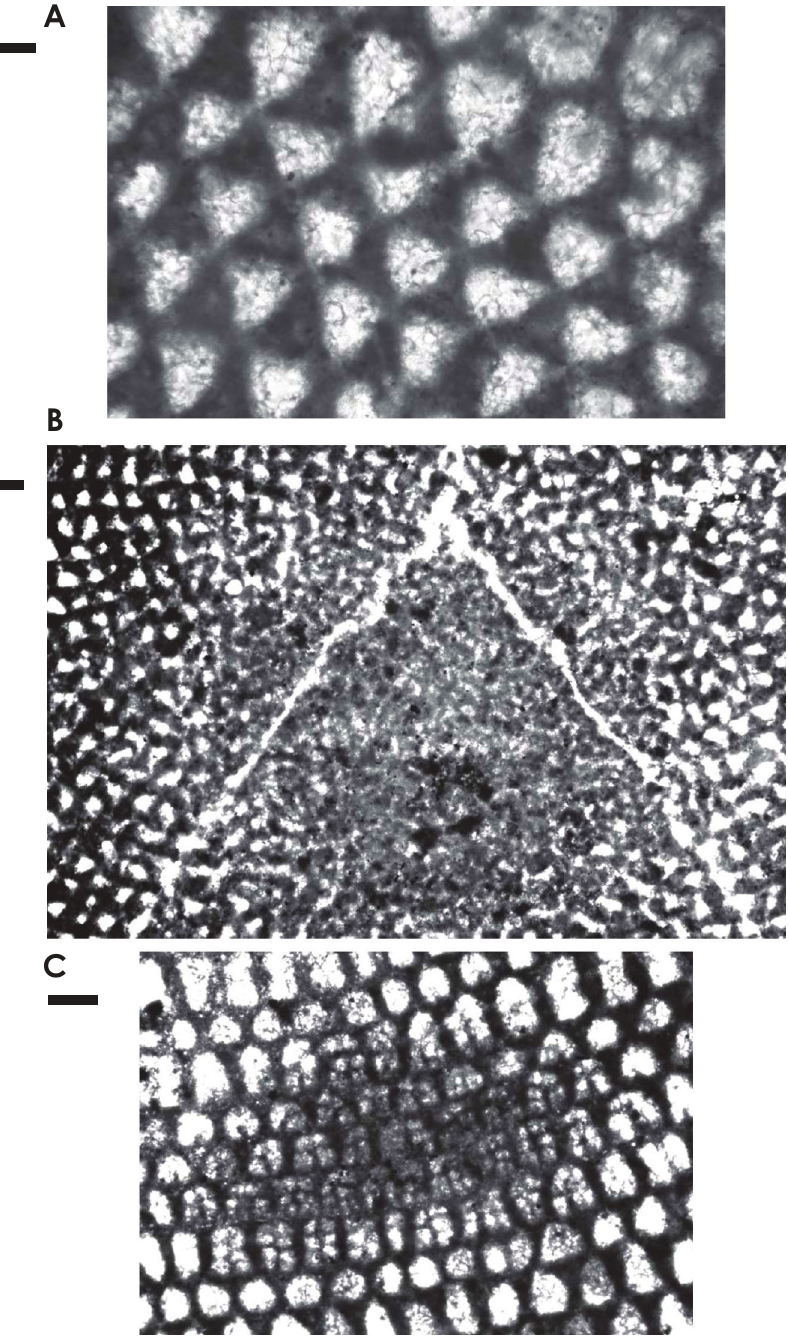
Enlargement of parts of Palorbitolina lenticularis (Blumenbach) figured by BouDagher-Fadel [1], scale bar = 100 μm. (A) Transverse section showing the triangular main partitions; (B) the same transverse section showing the central complex reticular part of the test; (C) the same transverse section showing the subdivision of the marginal chamberlets into